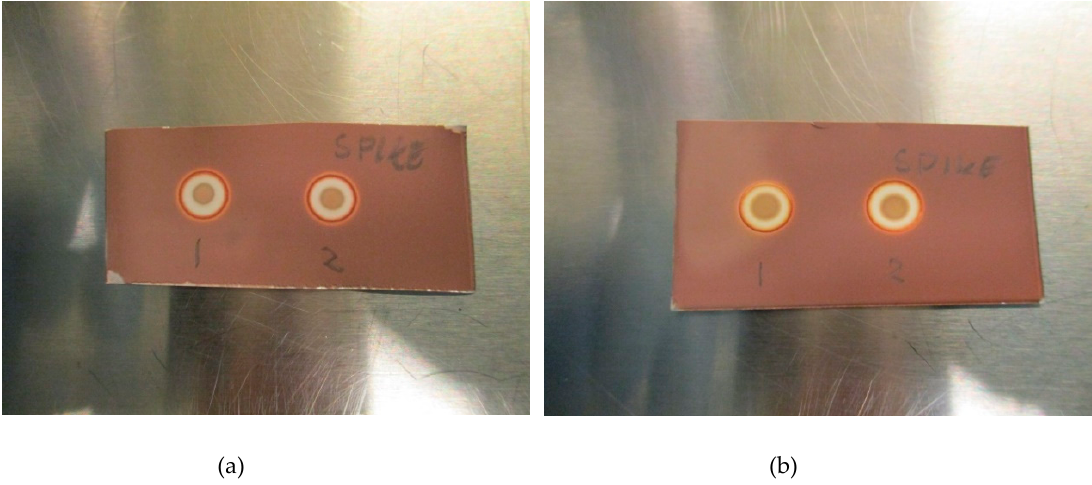
Figure 3. ( a ): Spike without antioxidant: (1) Matrix spiked with TBA, (2) [ 18 F]PSMA-1007 spiked with TBA. ( b ): Spike with antioxidant: (1) Matrix spiked with TBA, (2) [ 18 F]PSMA-1007 spiked with TBA.